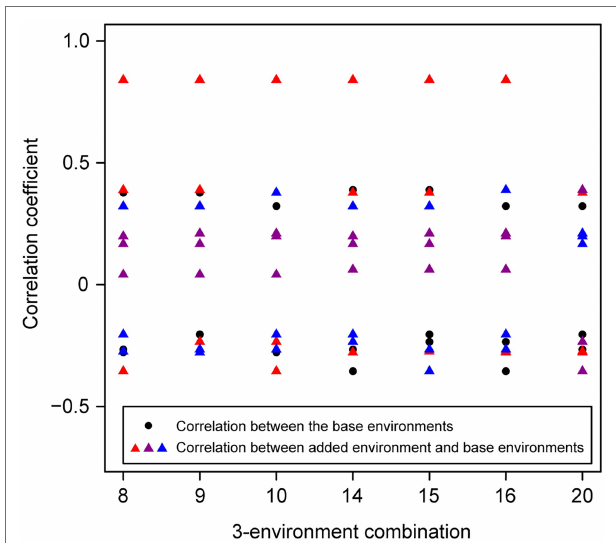
FIGURE 5 | Wheat – 3-environment combinations with complete phenotypic values showing statistically significant ( p < 0.05) lower response to selection than using total six environments with genomics-assisted sparse phenotyping. Labels of horizontal axis are the scenario numbers of 3-environment combinations. Black dots represent correlation coefficients between the three base environments with complete phenotypic values. Triangles with different colors indicate correlation coefficients between separate added environments, i.e., the first, second, or third added environment, and base